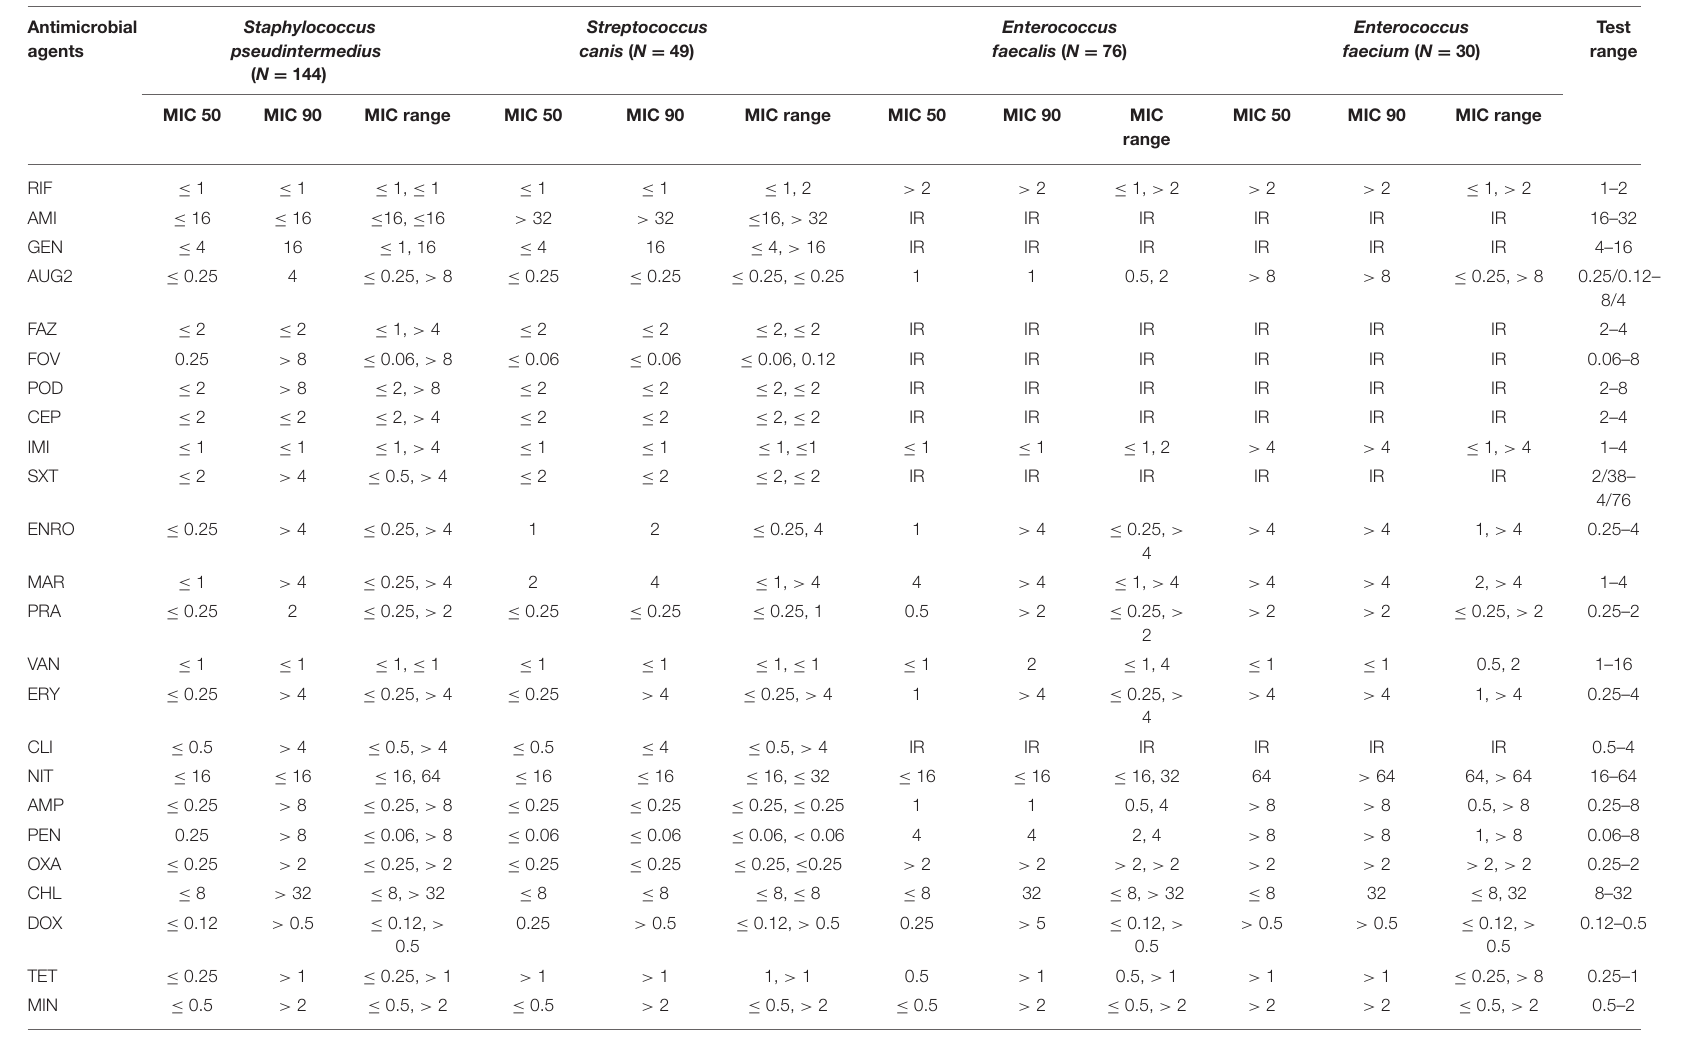
TABLE 2 | The MIC50 and MIC90 values of the Gram-positive bacterial